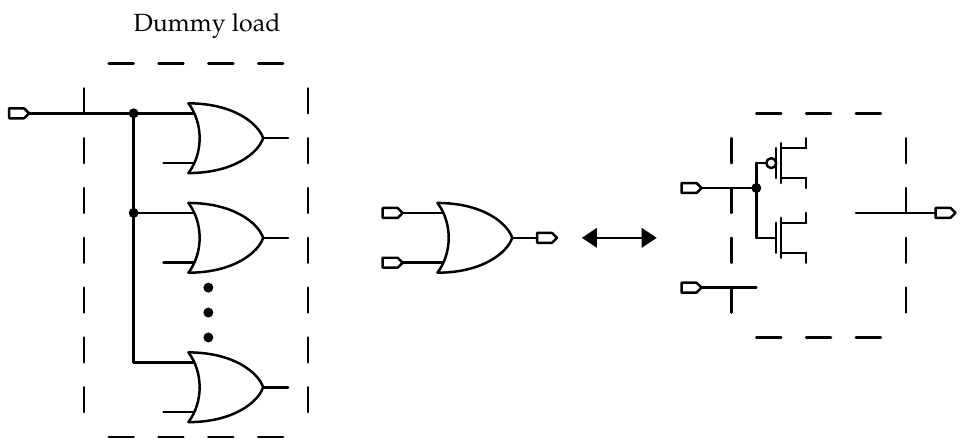
Figure 16. The dummy load for the dummy SA. This is used to emulate the input sections of multiple OR gates, which are embedded in each real MLSA/ANDSA, in order to take into account their influence on the sensing performance in the